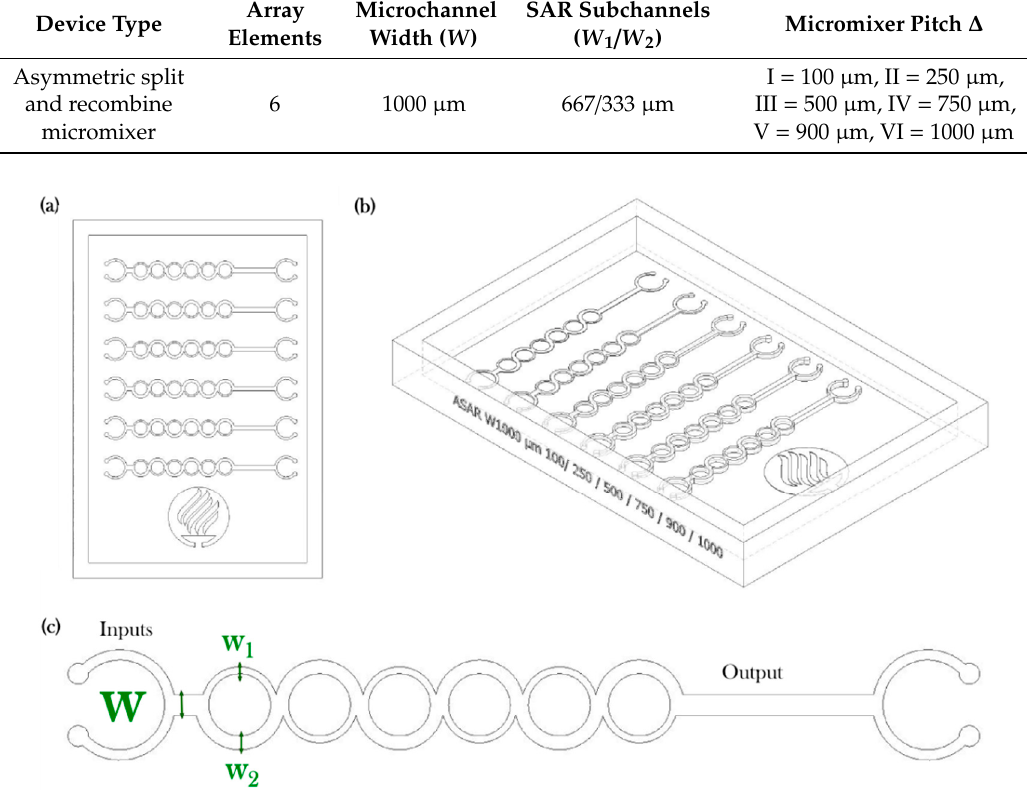
Figure 3. Soft tooling case study: ( a ) Top view, ( b ) Isometric view, ( c ) Detail of micromixer.